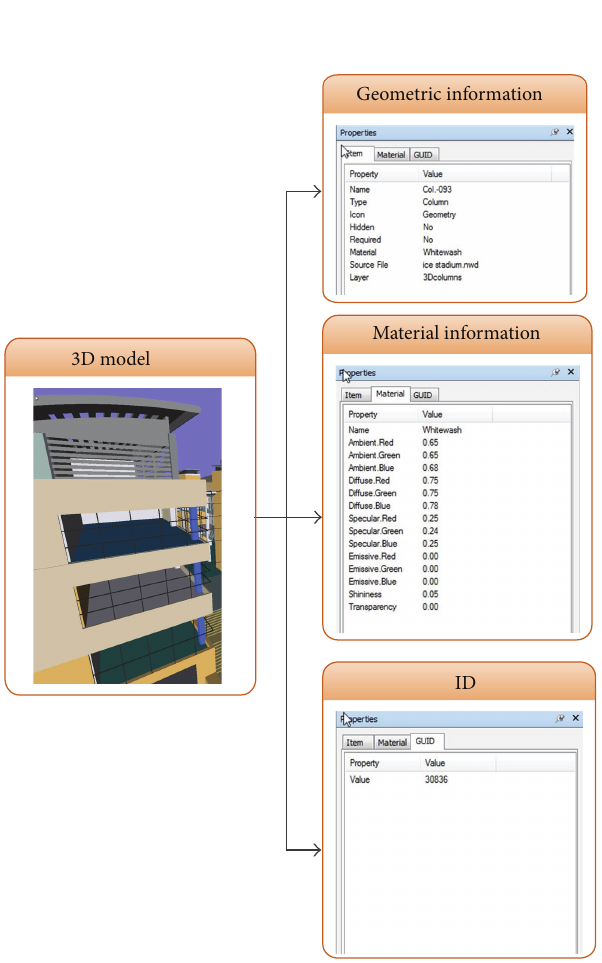
Figure 2: Column model and properties in